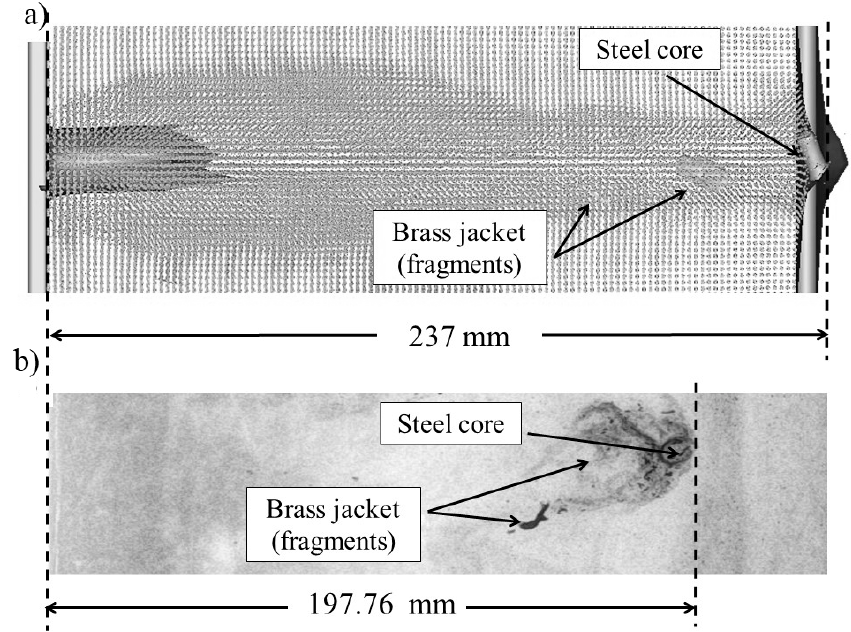
Figure 5. Comparison of fragmentation and penetration depths for the 7.62 mm AP bullet in the FSF block from ( a ) numerical simulation and ( b ) X-ray photography.